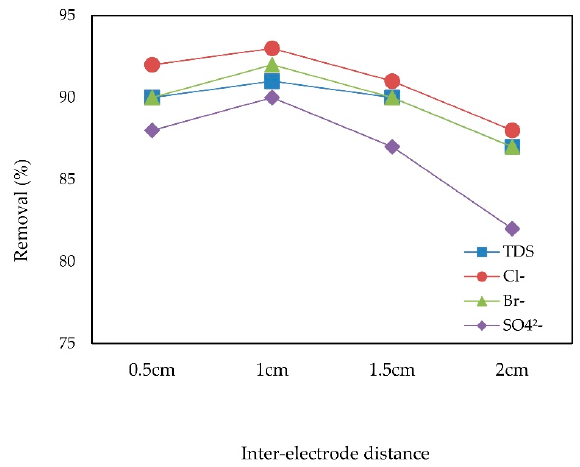
Figure 7. E ff ect of inter-electrode distance under optimal conditions (I = 2.0 mA / cm 2 , RT = 80 min, Figure 7. Effect of inter-electrode distance under optimal conditions (I = 2.0 mA/cm 2 , RT = 80 min, pH pH = 8, t = 25 ◦ C). = 8, t = 25 °C ).